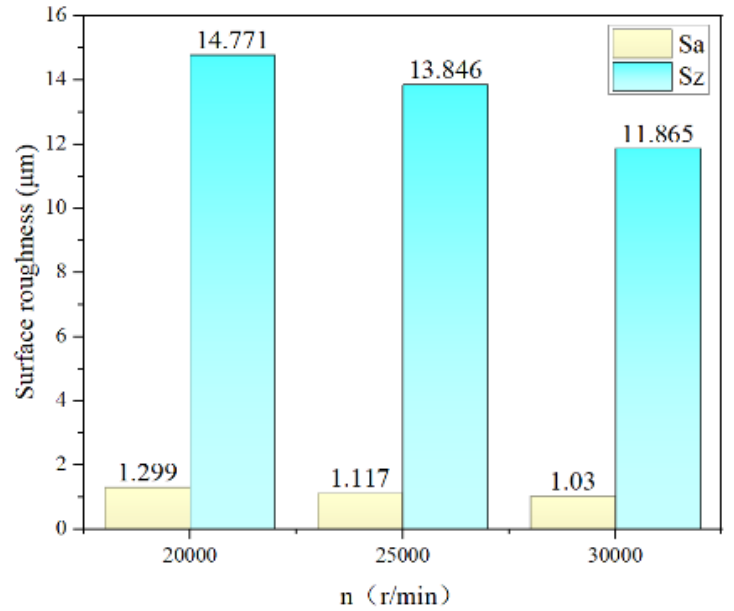
Figure 4. Surface roughness of different processing parameters.